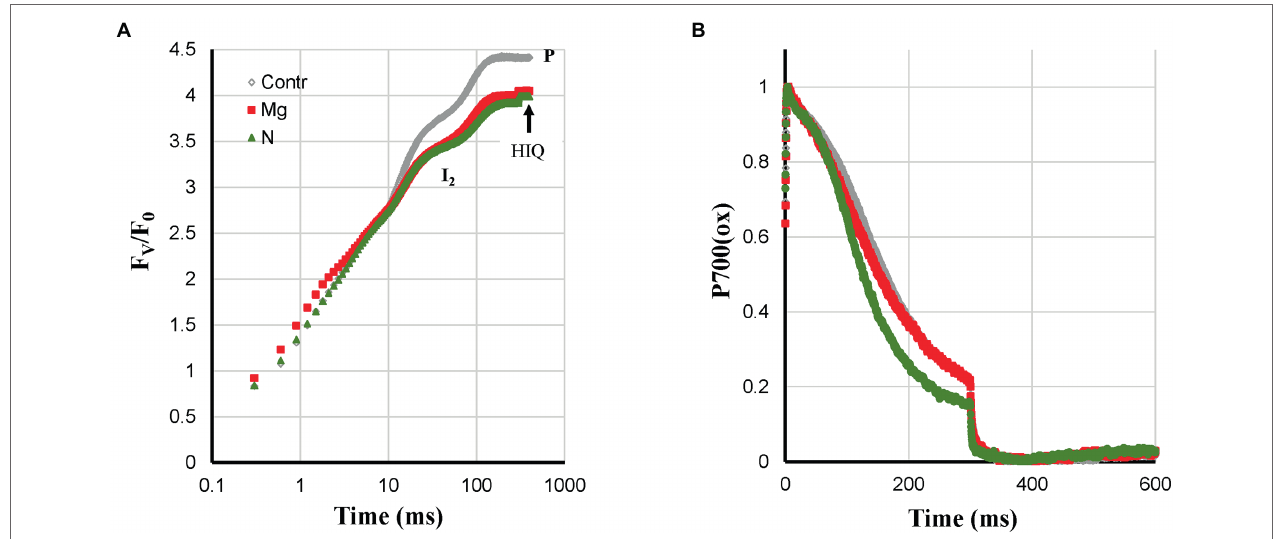
FIGURE 7 | Effect of Mg- and N-deficiencies applied to hydroponically grown sunflower plants on the polyphasic rise (A) and P700 + (B) kinetics, respectively. The transients are averages of four independent